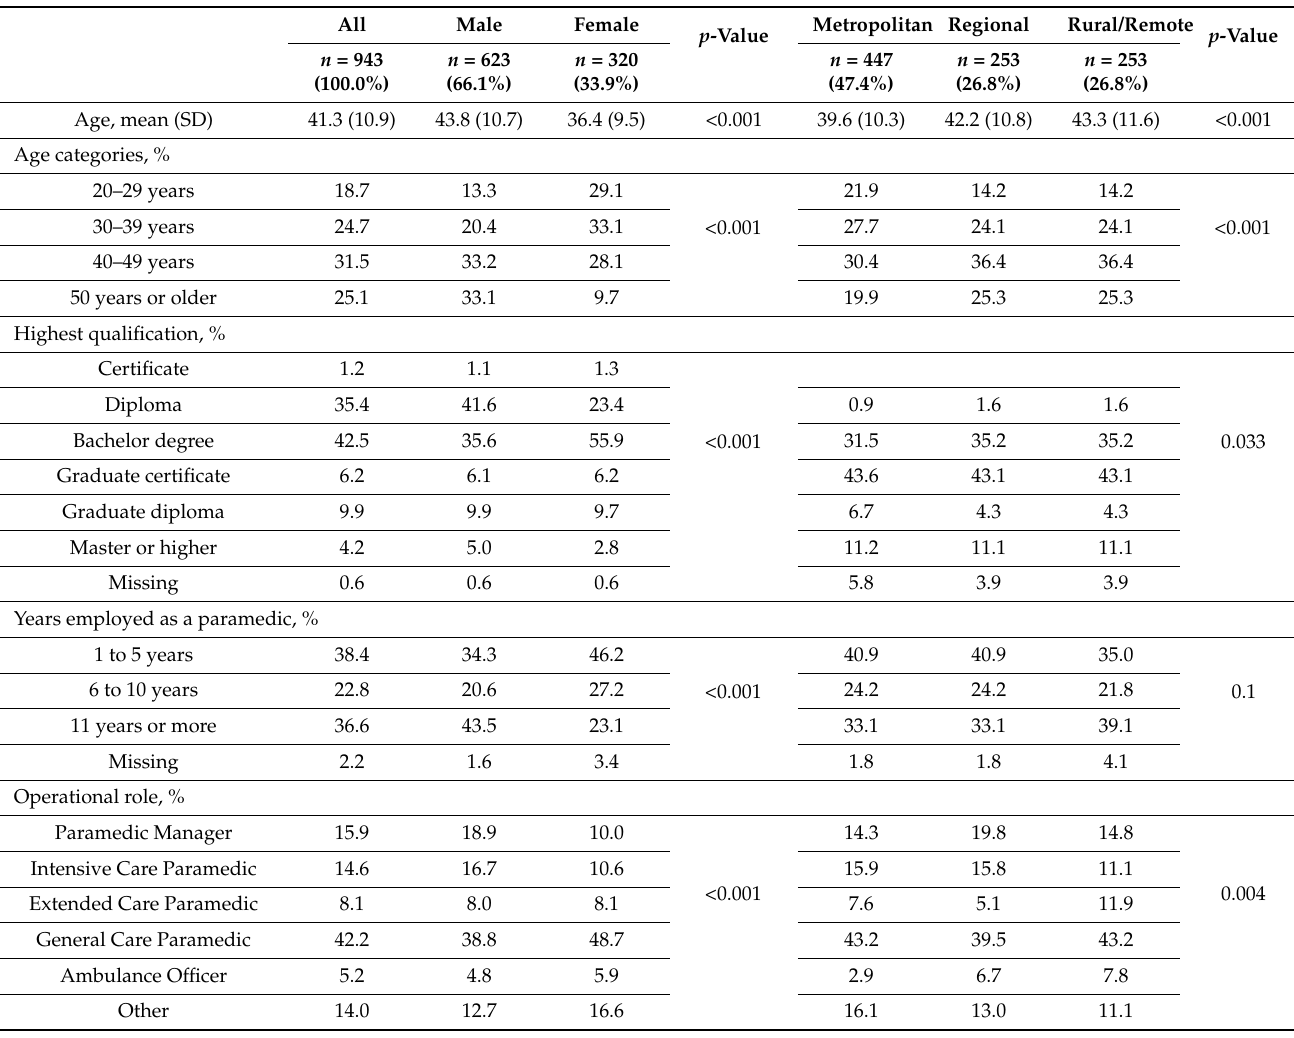
Table 1. Characteristics of paramedics by sex and region of practice.